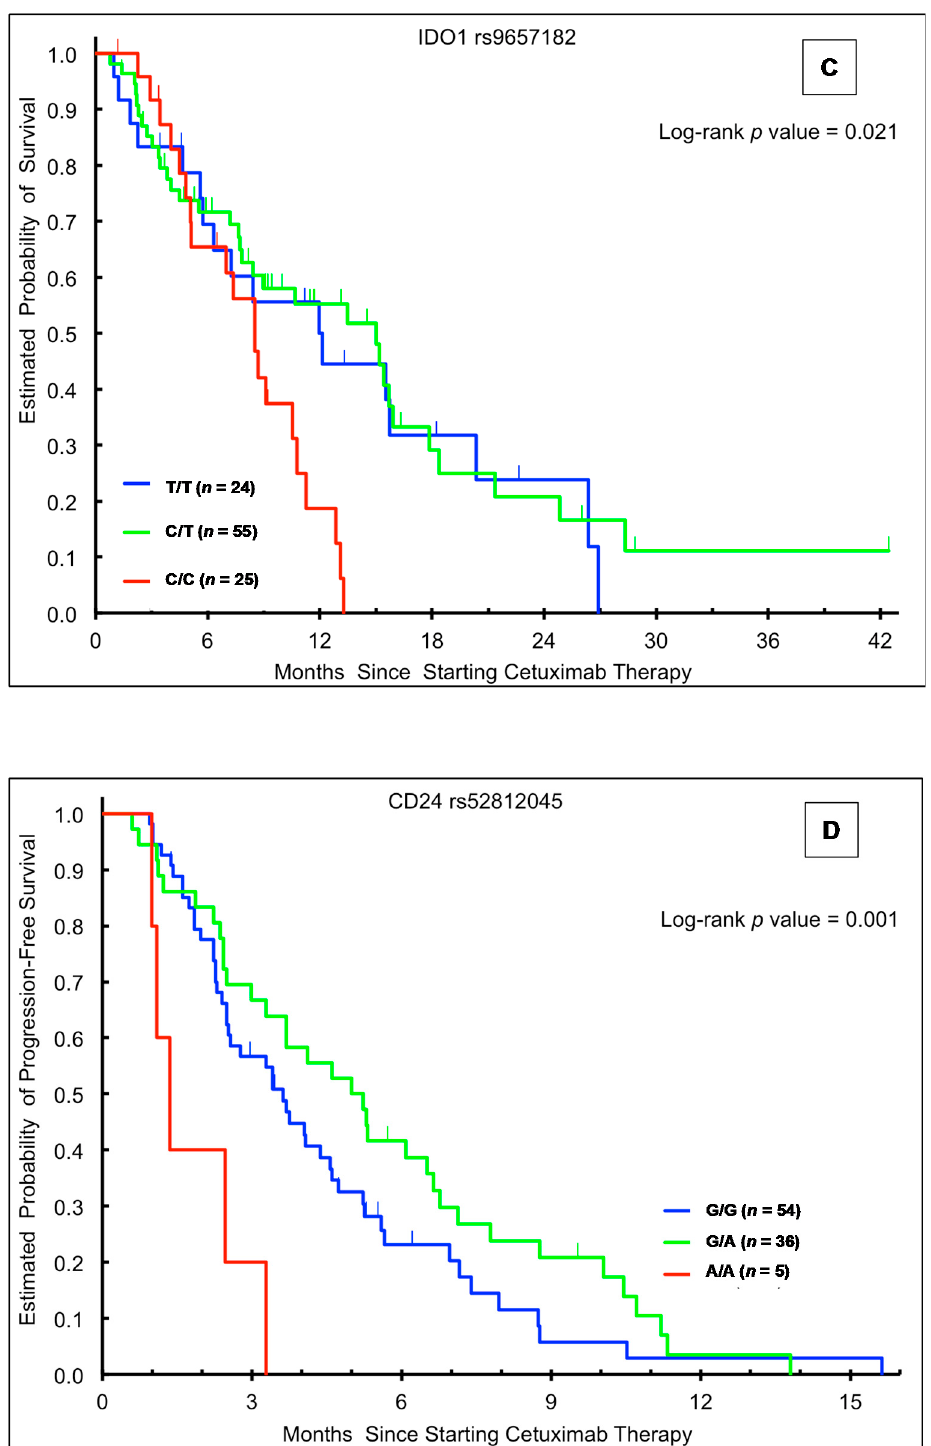
Figure 1. Kaplan-Meier plots according to genotype and outcome in the training cohort. ( A ) Overall survival (OS) stratified by CD24 rs52812045 genotype; ( B ) OS stratified by IDO1 rs3739319 genotype; ( C ) OS stratified by IDO1 rs9657182 genotype; ( D ) progression-free survival stratified by CD24 rs52812045 genotype.